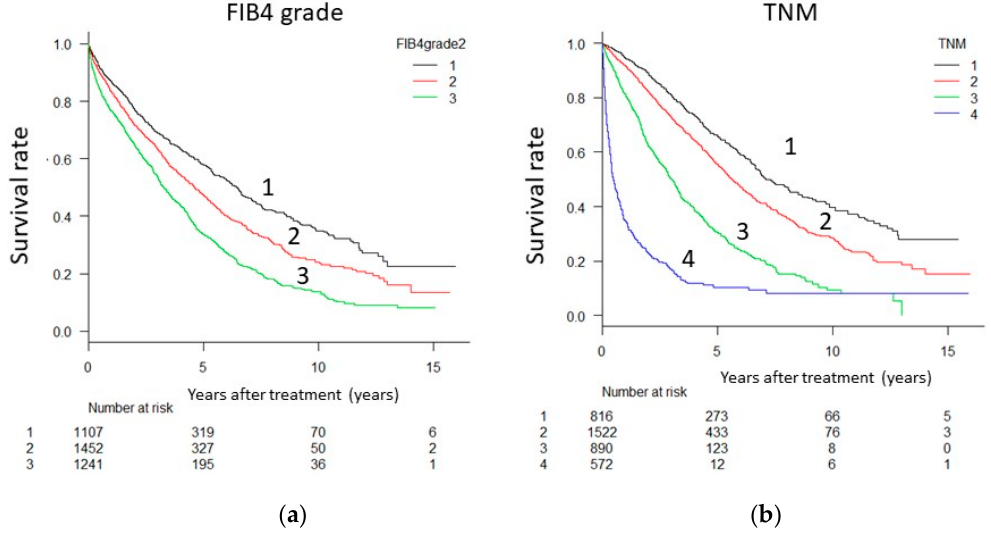
Figure 1. Kaplan–Meier curves according to ( a ) FIB4 grade and ( b ) Tumor, Node, Metastases (TNM) stage (data obtained from the Liver Cancer Study Group of Japan (n = 3800)). Statistically significant differences were observed among survival curves on the basis of FIB4 grade and TNM stage (log-rank test, p <0.0001).